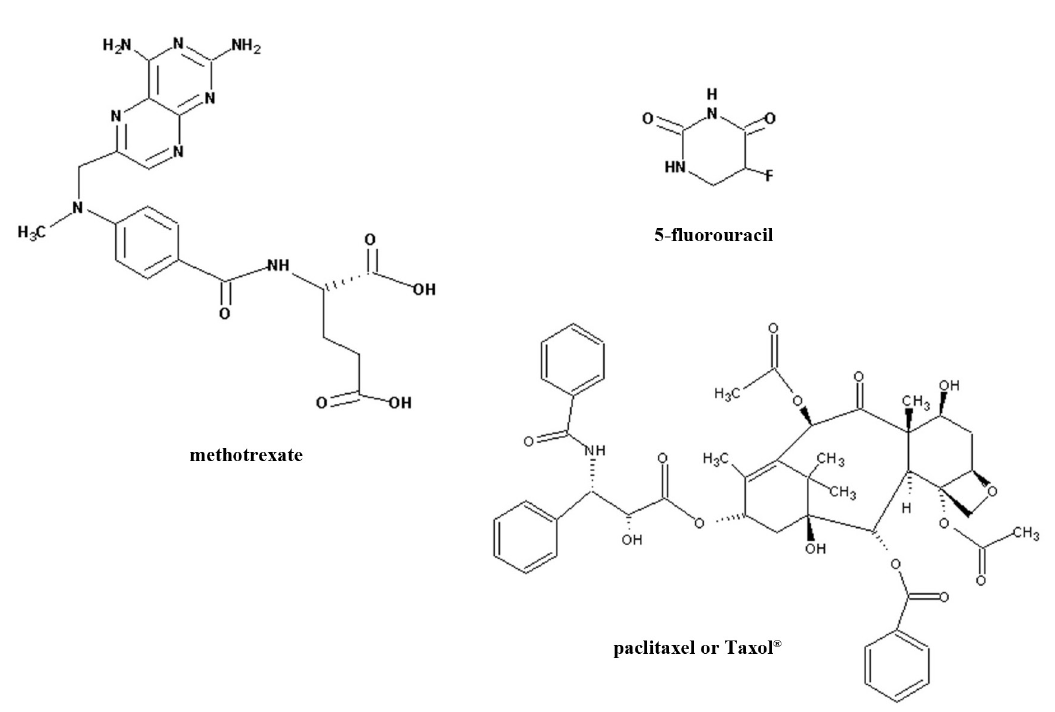
FIGURE 1 - Chemical structure of three antineoplastic drugs, frequently used in clinical practice . lung and breast. This drug is also classified as Group